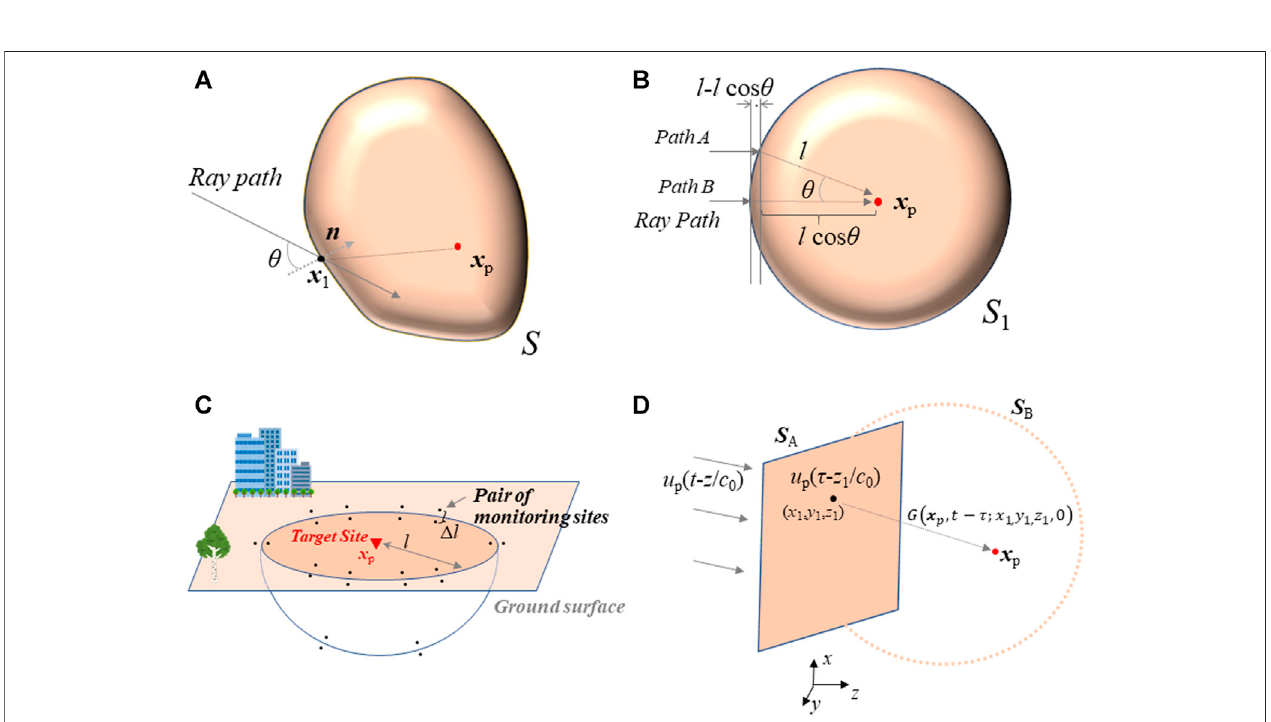
FIGURE2| Schematicillustrationoftheboundaryintegralequationmethod(AfterHoshiba, 2013a).Thesurface S canbetakenarbitrarilyaroundthetargetsite x p , and x 1 is a location on S , and n is the normal vector to S at x 1 . Here θ is the angle of incoming ray paths from the surface normal. (B) Surface S 1 is taken around x p as a sphereofradius l .Whenanincidentplanewaveisassumed,travel distance ofpath A islargerthan B by l - l cos θ . (C) Anexample ofdeployingpairs ofmonitoring sitesto predict ground motion at target site x p . The seismometer pairs are located at radius l on the ground surface and underground. Each seismometer in each pair is spaced by Δ l . (D) An example of plane wave propagation. The surface S is divided into S A and S B . S A is an in fi nite plane normal to the z axis, and S B is a half space of in fi nite radius. Incident plane wave normal to S A is assumed.